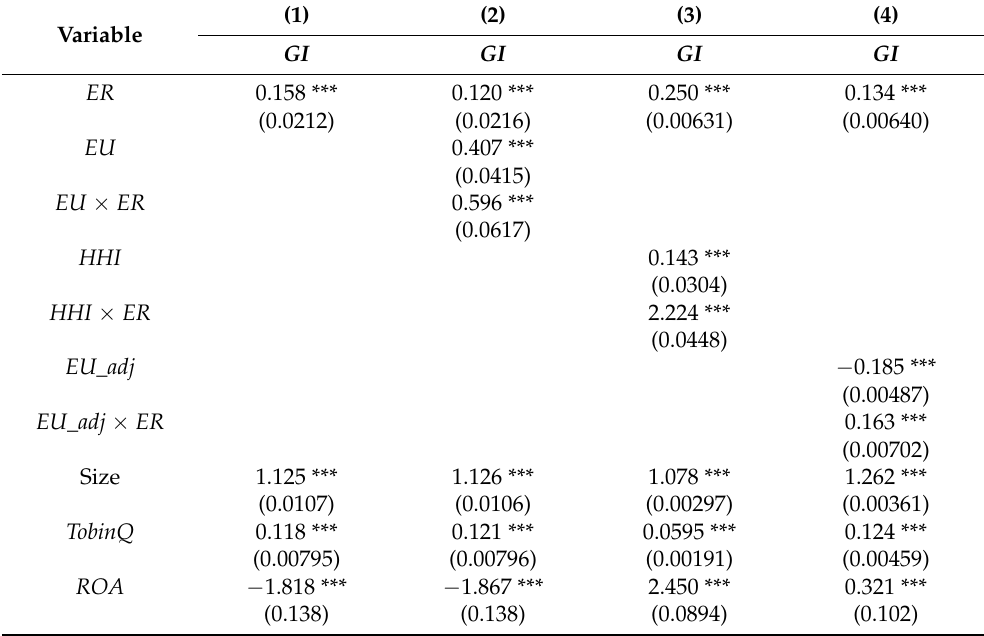
Table A6. Robustness Analysis of Environmental Regulation, Environmental Uncertainty and Enter- prises’ Green Technological Innovation Based on Poisson